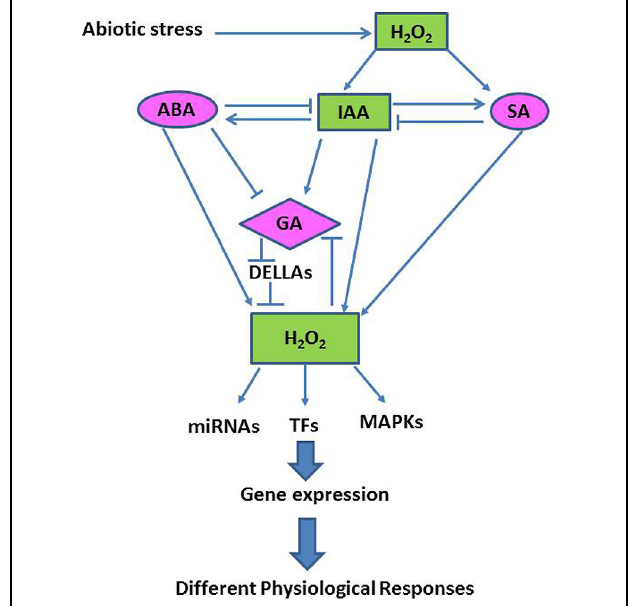
FIGURE 4 | A simplified schematic model showing interactions between the H 2 O 2 -transduced network and different hormonal signaling pathways in the plant cell (Adapted from Habibi,